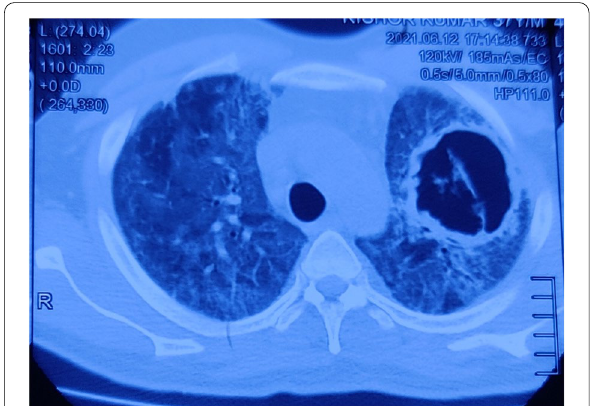
Fig. 3 HRCT-Chest showing diffuse areas of ground glass opacities with interlobular septal thickening in bilateral lung fields and left upper zone cavitary